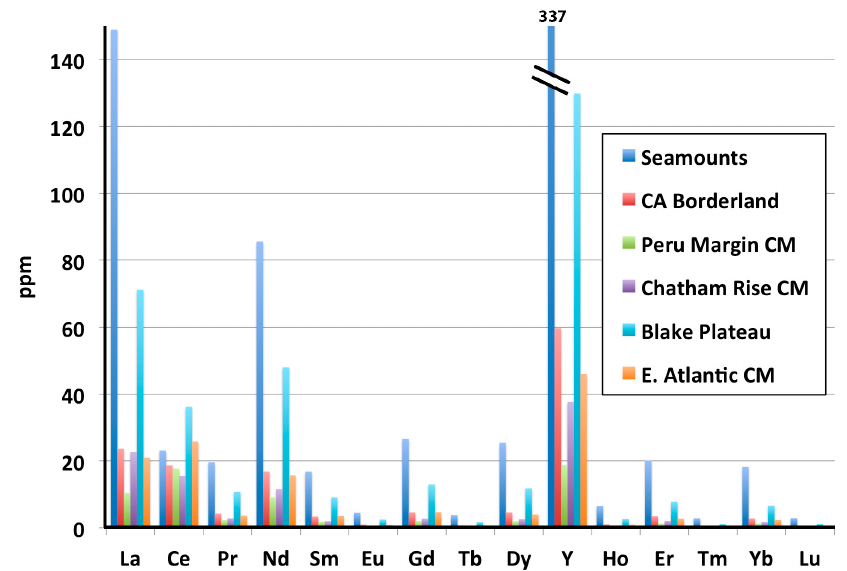
Figure 4. Bar diagram of mean contents of individual rare earth elements and yttrium for the sample groups studied here; note that the order for each element follows the order in the key.